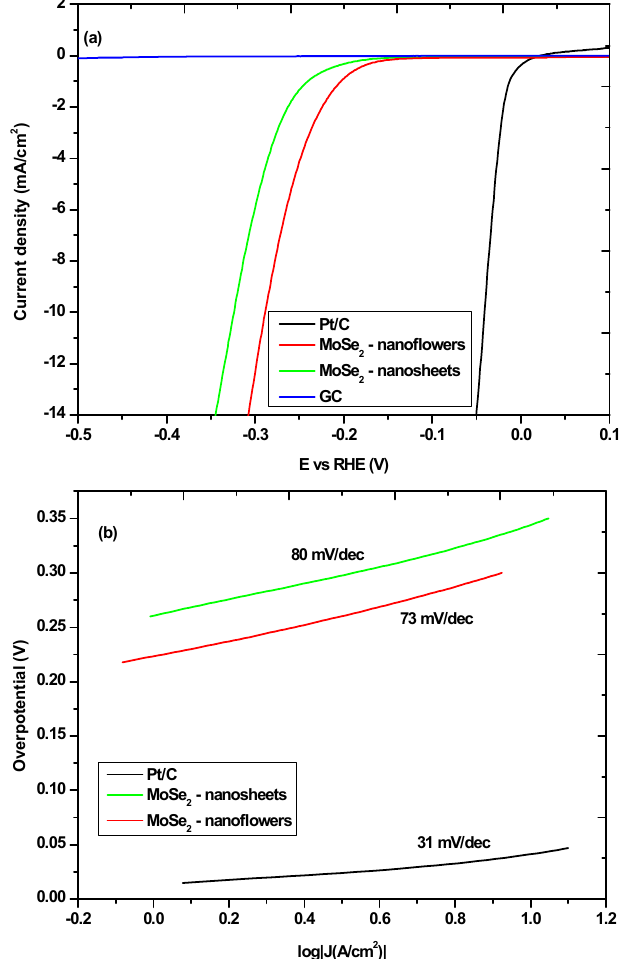
Figure 6. ( a ) Polarization curves for MoSe 2 nanosheets and MoSe 2 nanoflowers ( b ) Tafel slopes for MoSe 2 nanosheets and MoSe 2 nanoflowers.